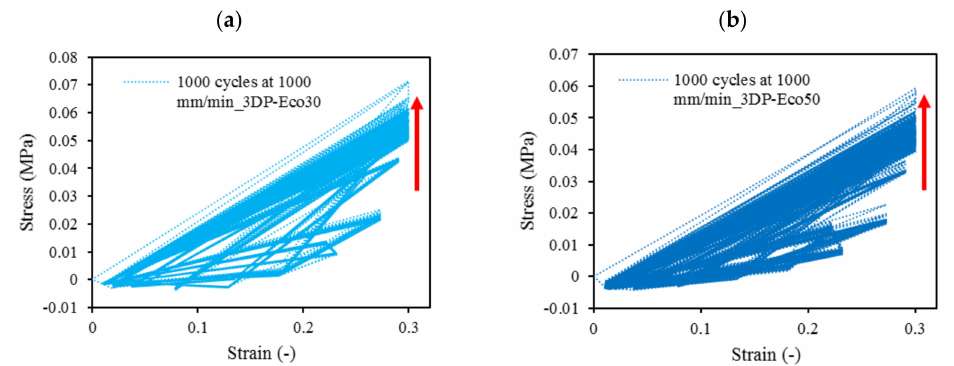
Figure 14. The 1000-cycle cyclic stress-strain for ( a ) 3DP-Eco30 and ( b ) 3DP-Eco50, at a strain rate of 1000 mm / min.